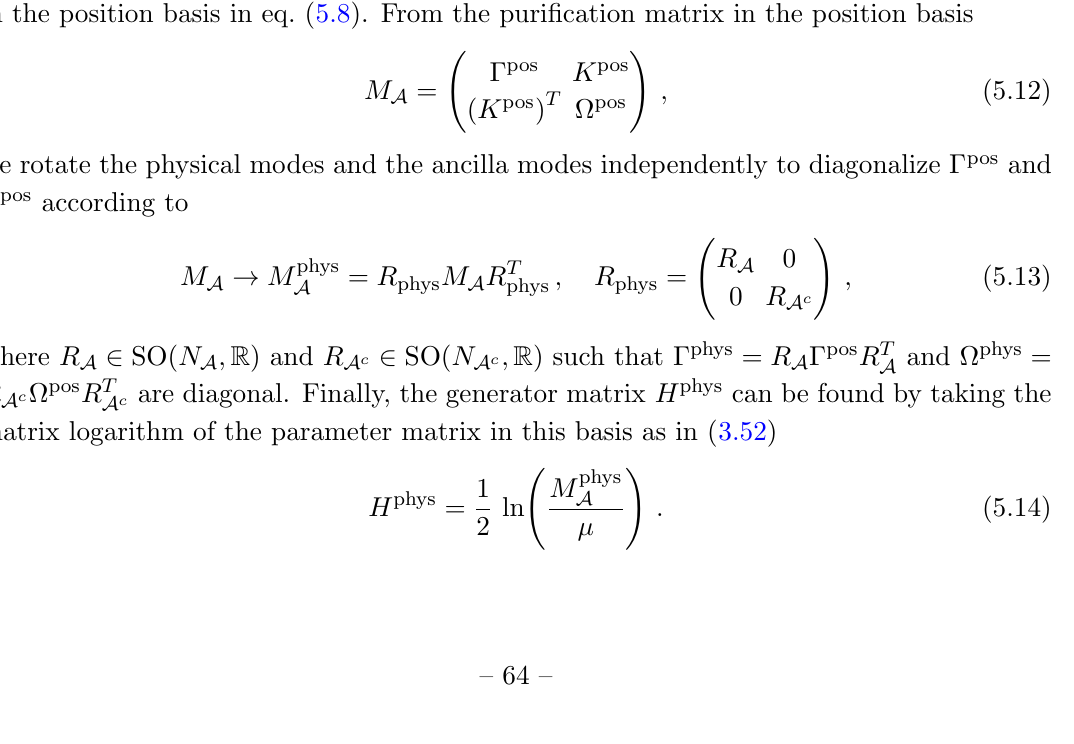
Figure 18 . Cuto(cid:11) dependence of the mutual complexity in the diagonal basis (cid:1) C diag reference frequencies (cid:22)L = 100, 200, 300, 400 and 500. The subregion sizes were (cid:12)xed to ‘=L = 0 : 1 and 0 : 05 and the mass to mL = 0 :